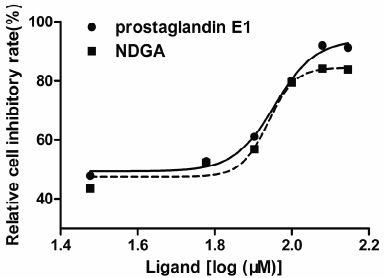
Figure 6. Effect of prostaglandin E1 and NDGA on cell proliferation in cultured HepG2 cells.